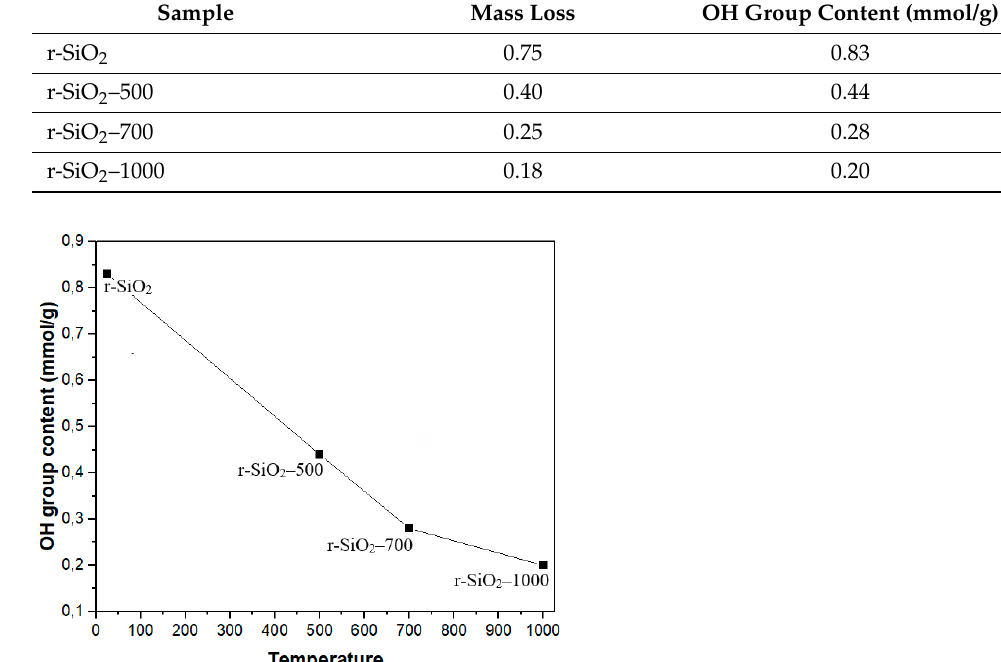
Table 4. The mass loss and hydroxyl group content obtained from Equation (2) for the samples from 200 to 900 °C.